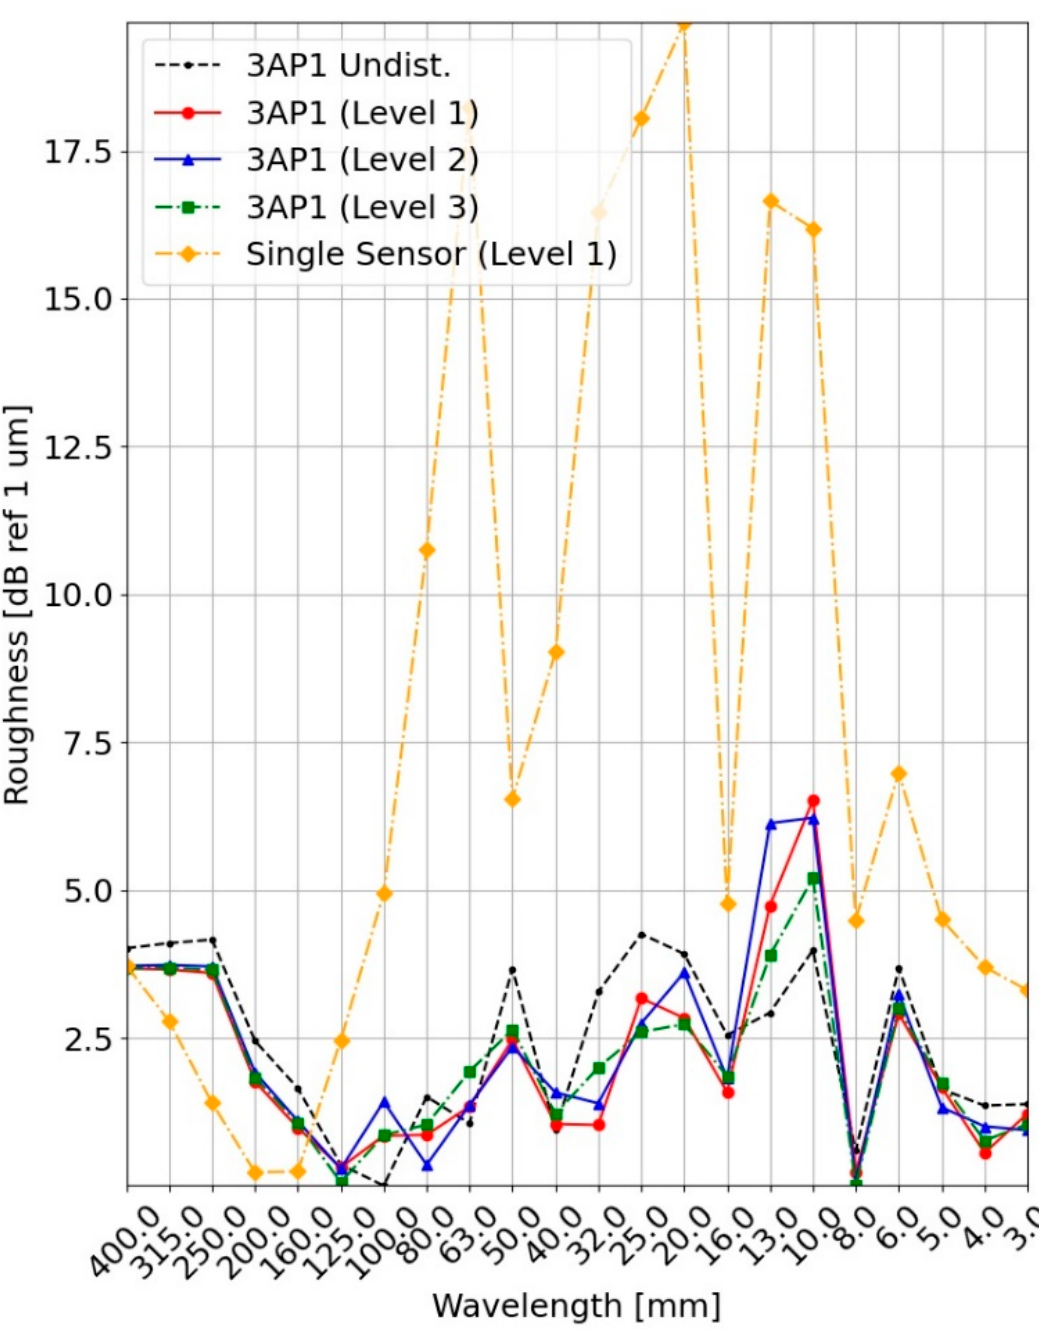
Figure 9. Absolute error of acoustic roughness for measurements with vibration applied to the sensor plate (frequency indicated as levels).